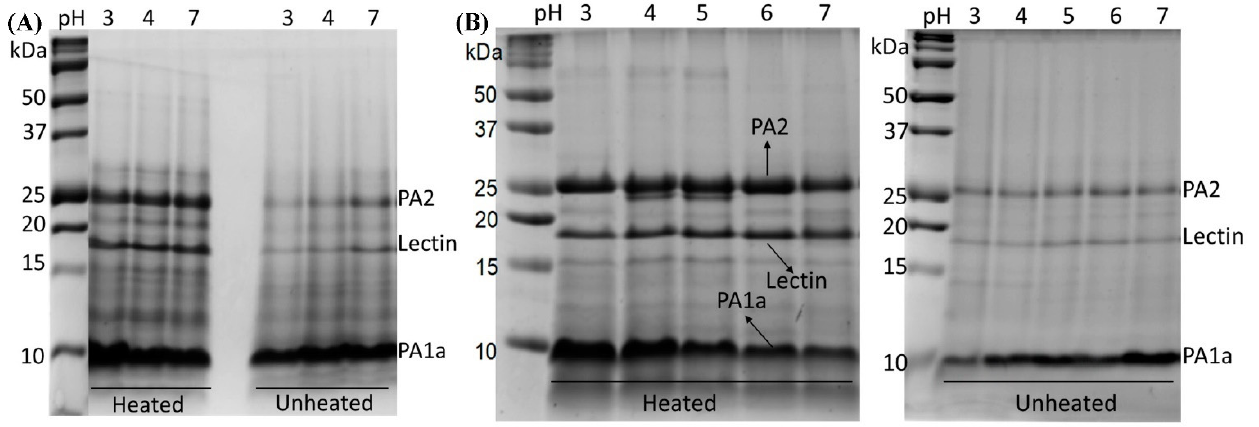
Figure 5. Interfacial protein composition of emulsions stabilized by ( A ) PAs alone and ( B ) PA/DS soluble complexes.